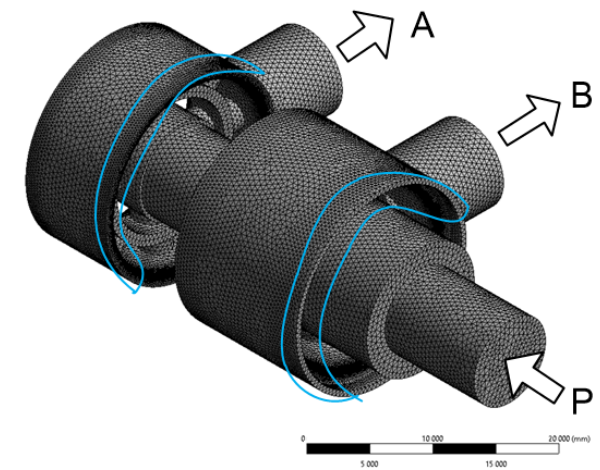
Figure 6. Meshed model of the fluid; P, A, B—connection ports.